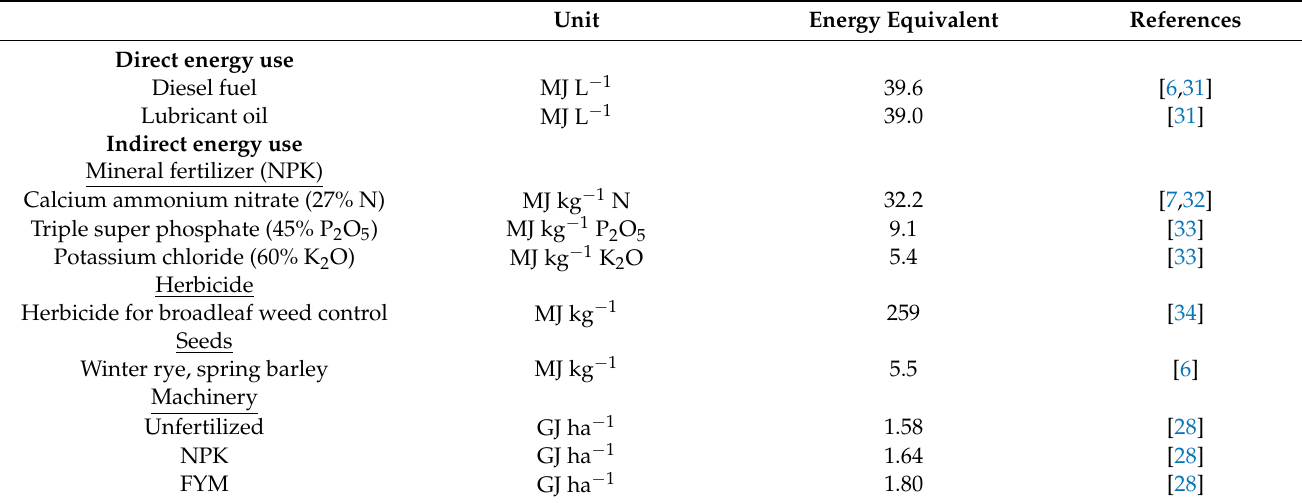
Table 4. Energy equivalents used in this